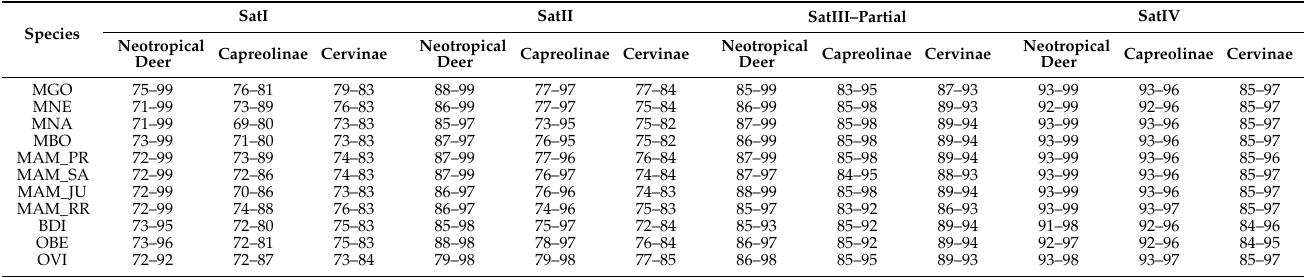
Table 3. Satellite DNA sequence similarity among Neotropical deer, Capreolinae, and Cervinae (Cervini and Muntjacini). SatI Species